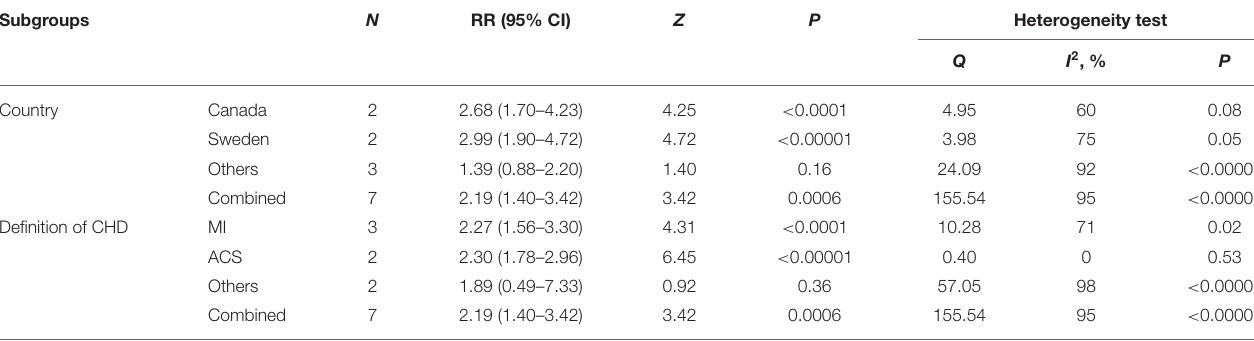
TABLE 3 | Subgroup analysis of CHD risk in IIMs patients. Subgroups